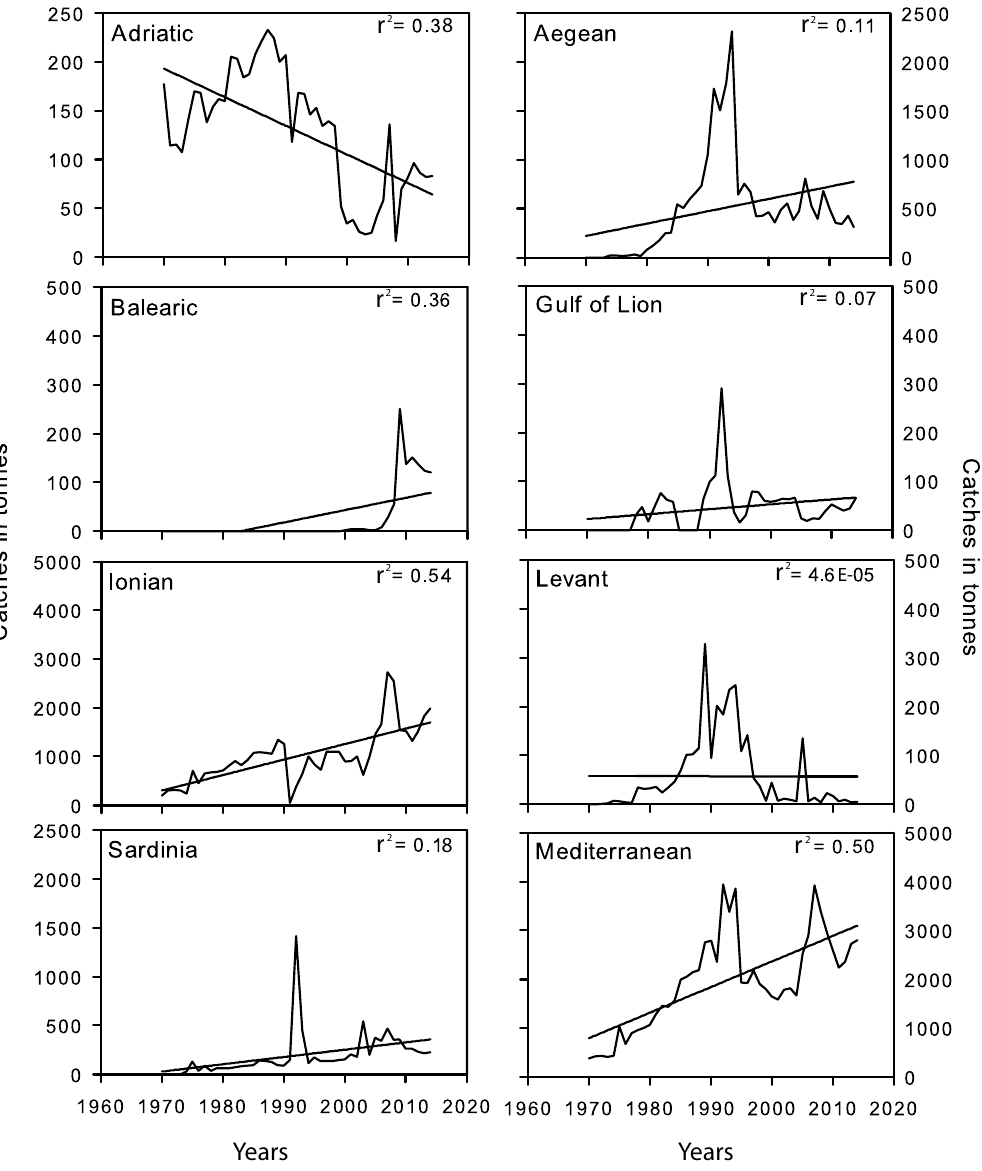
Figure 10. Patterns of temporal variation in salema landings. Salema catches (in tonnes) are represented for 7 distinct basins (FAO sub-areas) and the Mediterranean as a whole from 1970 to 2014 ( x -axes). Trend lines and the r-squared values are reported on each graph. Note different scales among catch